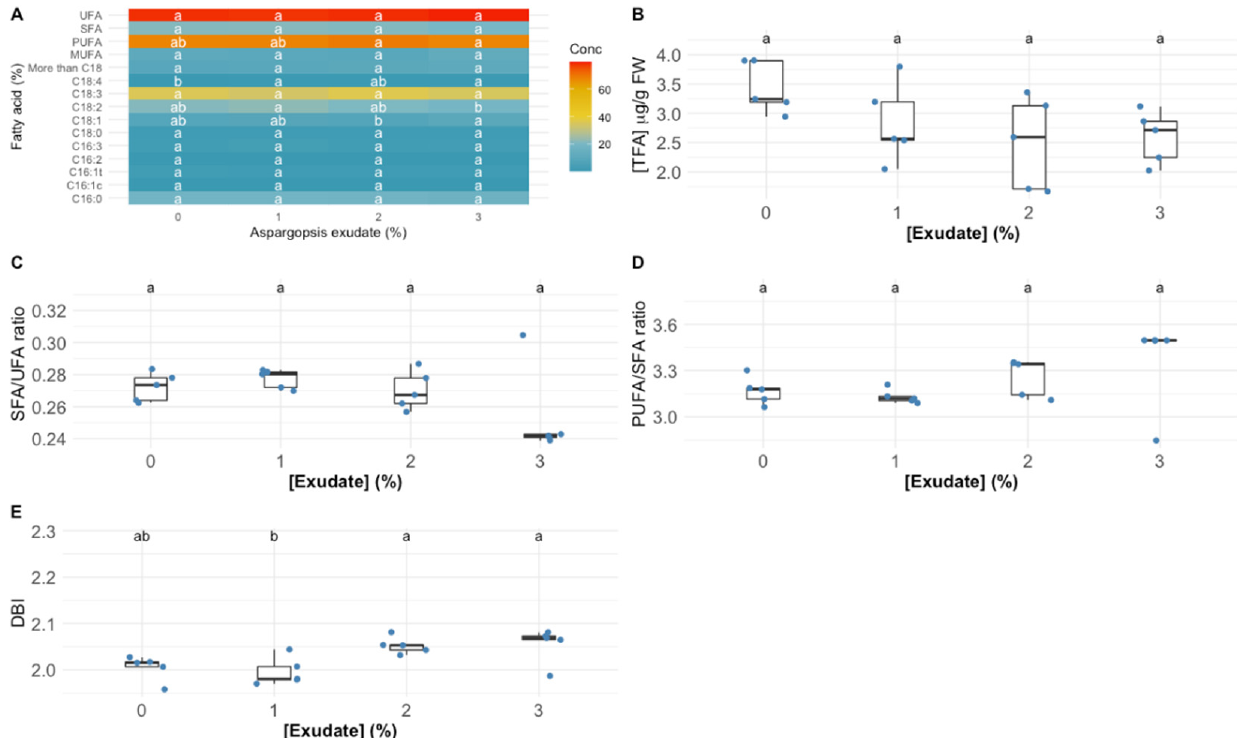
Figure 5. Thellungiella halophila leaf individual fatty acid and unsaturation classes ( A ) relative concentrations (UFA—unsaturated fatty acids; SFA—saturated fatty acids; PUFA—polyunsaturated fatty acids; MUFA—monounsaturated fatty acids) (%, average ± standard error, N = 5), total fatty acid content (TFA) ( B ), unsaturation ratios ( C , D ) and double-bound index (DBI) ( E ) in the plants exposed to Asparagopsis armata exudate at the proposed target concentrations at the end of the trial period (N = 5 per treatment; letters denote significant differences between treatments at p < 0.05).